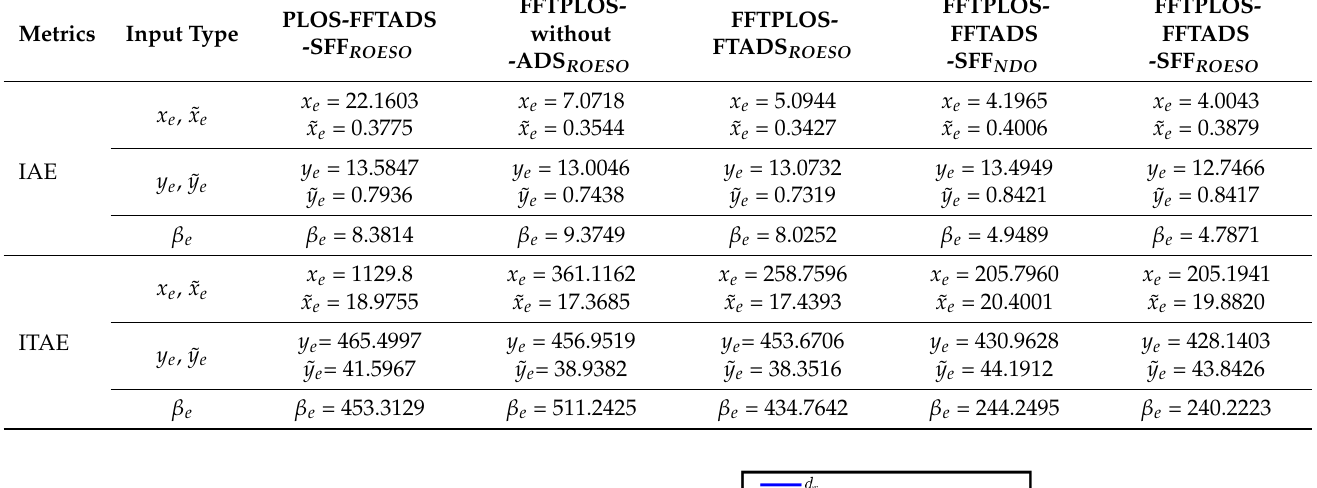
Table 2. Path-following performance of different methods.